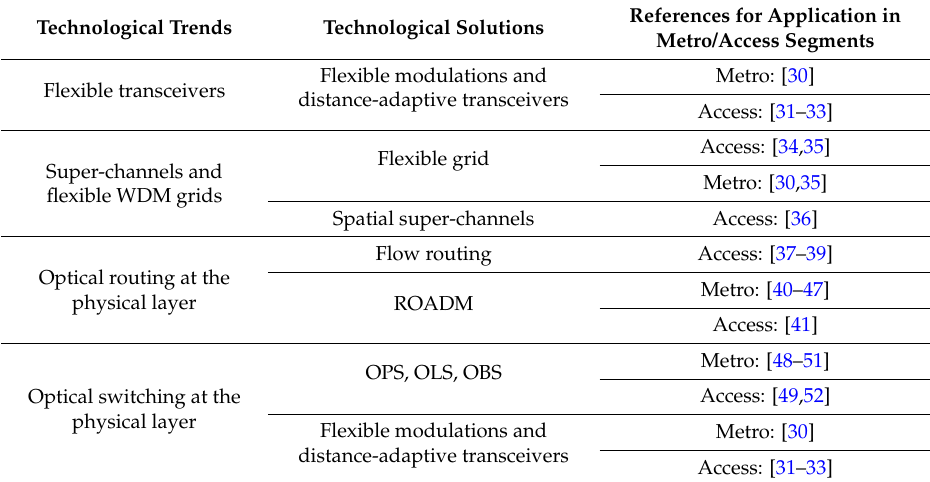
Table 1. Technologies designed for the core networks and extendible to metro and/or access